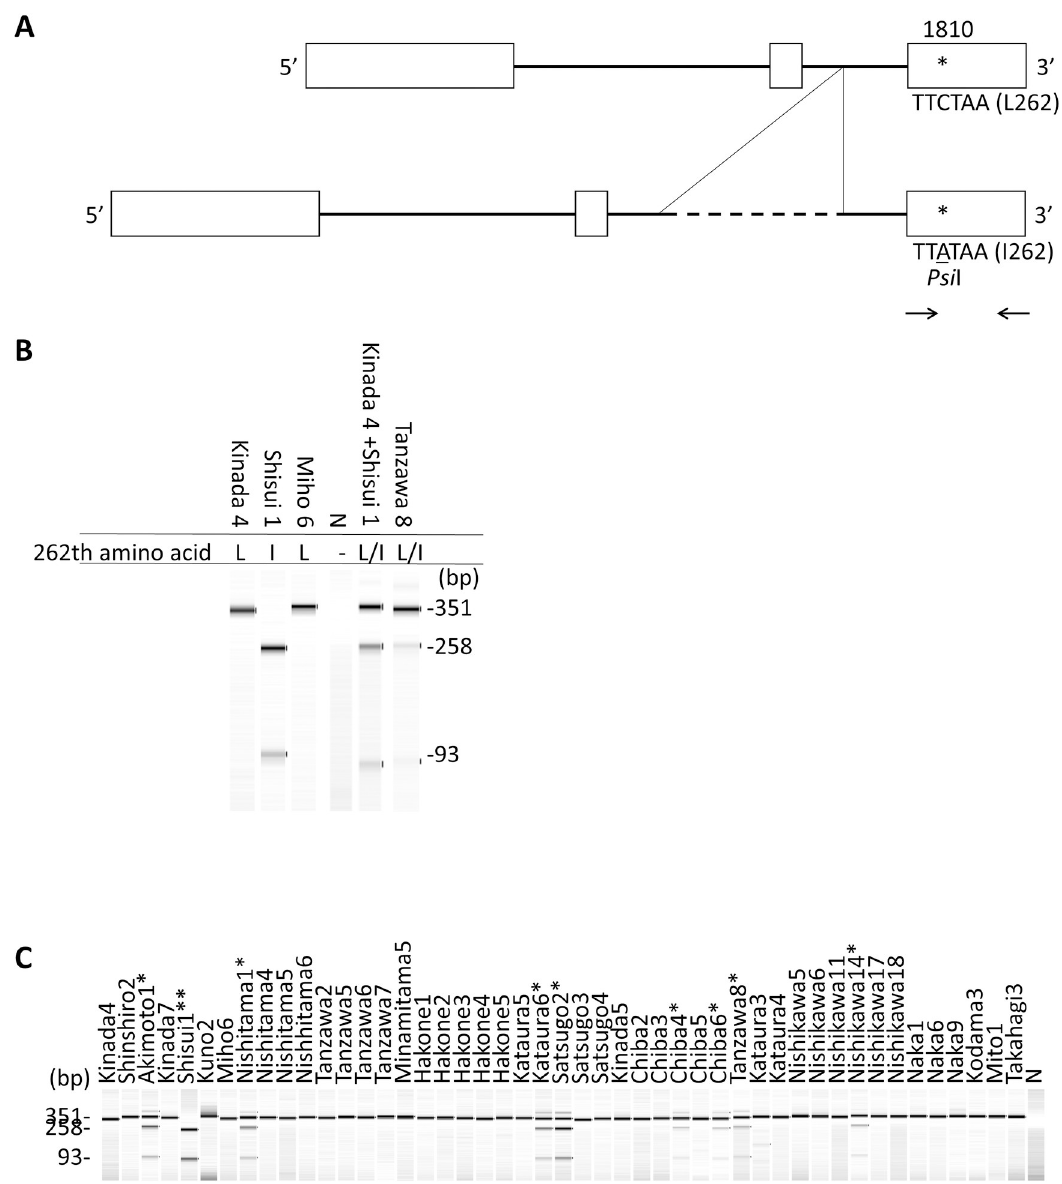
Fig 3. Cha o 1 gene organization. The genomic DNA of the Cha o 1 gene from the plus tree Miho 6 was amplified and sequenced (Genbank accession number #LC586088). (A) Comparison with the cDNA sequence of Cha o 1 reported previously (Genbank accession number #D45404) [14]. The exon and intron structures were determined. The DNA sequence for the exon of Cha o 1 from Miho 6 was identical to reported cDNA and was used as the reference sequence for NGS in this report. Cha o 1 genomic DNA of the Shisui 1 plus tree has a second intron that is ~0.6 kb longer and the 1810th nucleotide (asterisk) is mutated from cytosine to adenine, which gives rise to the L262I substitution. The newly formed SNP afforded the Psi I restriction site, TTATAA . Primer pairs for PCR amplification and detection of the SNP are shown as arrows. (B) Electrophoresis of the restricted PCR product by Psi I. PCR products of Kinada 4, Miho 6 were not restricted by Psi I, which indicates that residue 262 of them are Leucine. The PCR product from Shisui 1 was completely restricted, which indicates that residue 262 is Isoleucine. From a mixture of Kinada 4 and Shisui 1, an artificial heterozygote for the substitution was prepared and its PCR product was partially restricted. A similar band pattern was obtained from Tanzawa 8, which indicates that residue 262 was a mixture of Leu and Ile. (C) PCR-RFLP analysis of the 47 mother trees from the seed orchards of Chiba Prefecture. PCR products of the 3 rd exon of Cha o 1 were analyzed for the presence of the Psi I recognition site. Homozygotes ( � ) and heterozygotes ( �� ) for the substitution of Cha o 1[L262I] are shown. N: negative control, PCR product without template treated with Psi I.